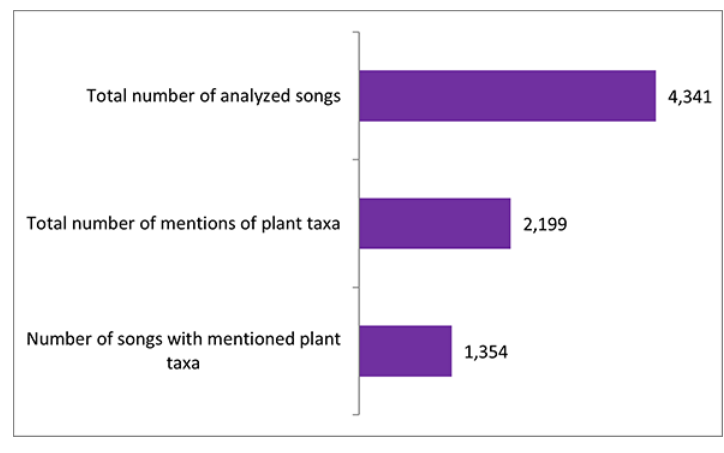
Figure 1 e number of songs containing vascular plant citations and the total number of analyzed songs and plant mentions.